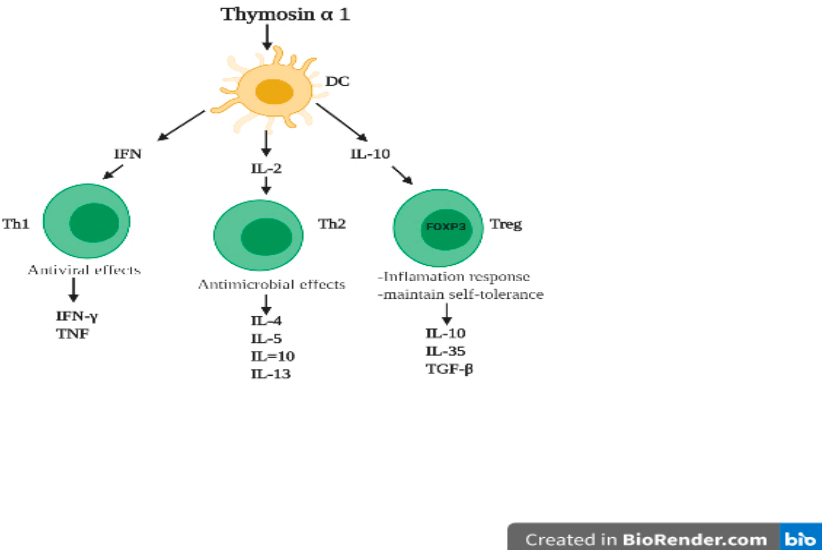
Figure 5. T alpha 1 cells and functional outcomes by targeting dendritic cells. T α 1 cells can modulate dendritic cell (DC) function. DCs express variable receptors for communications to induce T helper type 1 (Th1), T helper type2 (Th2), and regulatory T cells (Treg) priming antigen-specific T cell activation. T α 1 cells convert resting DCs into cells capable of promoting the polarization and differentiation of naive T cells.